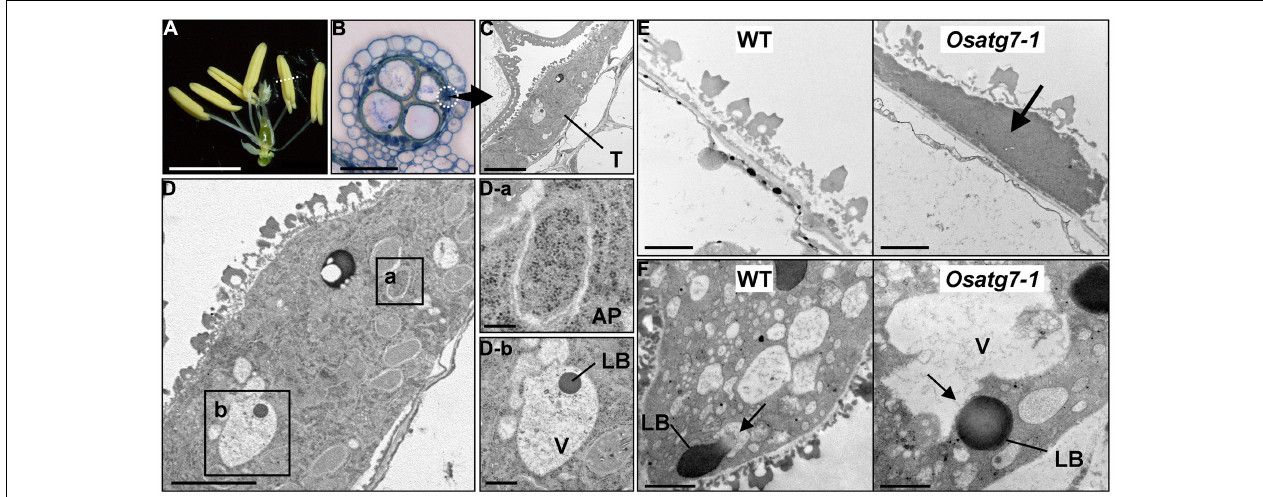
FIGURE 1 | Rice autophagy-defective mutants exhibit sporophytic male sterility, and autophagic degradation within tapetal cells is essential for postmeiotic anther development. (A) Anthers in the wild-type at the uninucleate stage. Scale bar: 3 mm. (B) Transverse sections of wild-type anthers stained with hematoxylin at the uninucleate stage. Scale bar: 50 μ m. (C,D) Autophagosome-like structures and lipid bodies enclosed within the vacuoles detected in postmeiotic tapetum cells during pollen development are depicted. Scale bars: 5 μ m (C,D) and 1 μ m (D-a,b) .